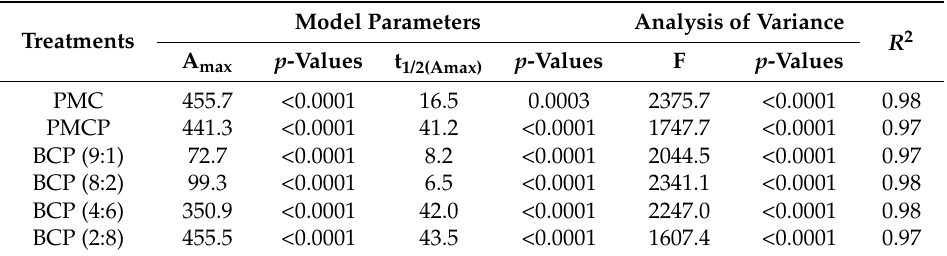
Table 2. Estimation model for accumulated NH 4 -N releasing from different combination rates of biochar